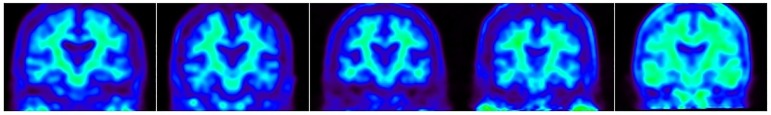
Sample 18F-florbetapir PET images.From left to right: 66-year-old normal control (MMSE, 30), 73-year-old individual with SMC (MMSE, 29), 84-year-old subject with EMCI (MMSE 27), 64-year-old subject with LMCI (MMSE 26), 71-year-old patient with AD (MMSE 19). All images were scaled to the same maximum. PET images show clear differences in the cortical region between AD and NC, but not LMCI, EMCI, SMC vs. NC visually.